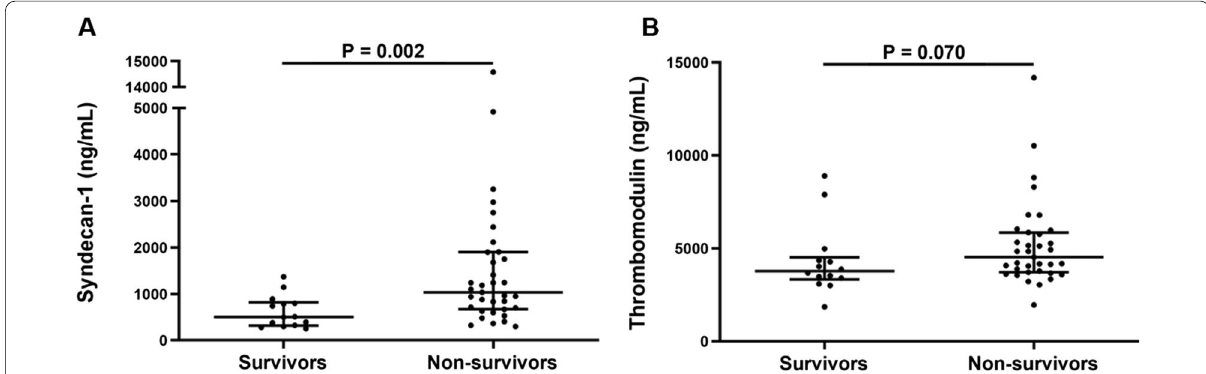
Fig. 1 Levels of syndecan-1 and thrombomodulin in survivors and non-survivors COVID-19 patients. A The levels of syndecan-1 were significantly higher in non-survivor group compared with survivor group. B The levels of thrombomodulin were not significantly different between non-survivor group and survivor